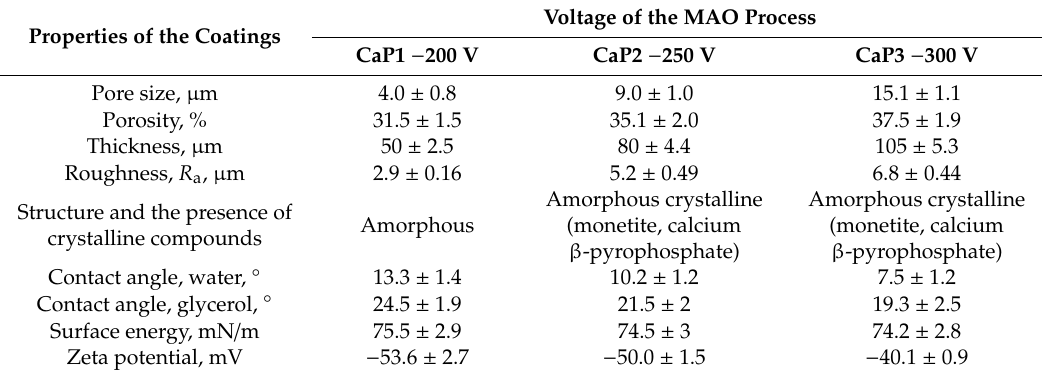
Table 1. Properties of CaP coatings depending on the applied voltage of the MAO process.